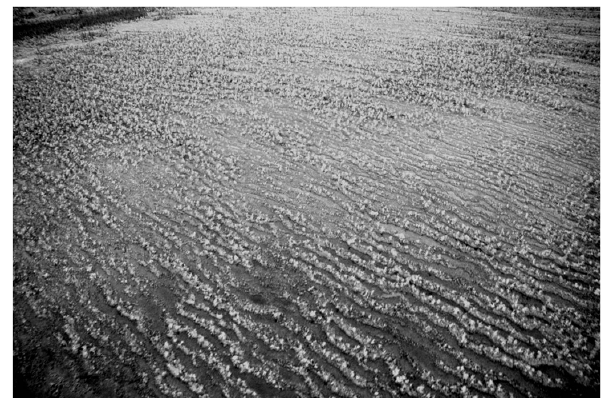
Figure 1. Aerial photograph showing contour-parallel, striped pat- terning on a peatland complex in the James Bay lowlands, Ontario, Canada. The directions of slope and regional water flow are from the top right to the bottom left of the picture. Horizontal distance between tops of successive ridges is approximately 5 to 10m. Image belongs to Brian Branfireun, reproduced here with kind